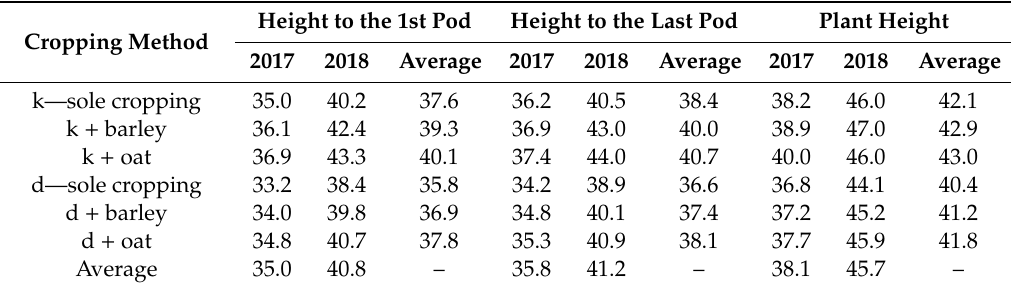
Table 6. Height to the first pod, height to the last pod and height to top of chickpeas (cm), depending cropping method and type (k—kabuli; d—desi).